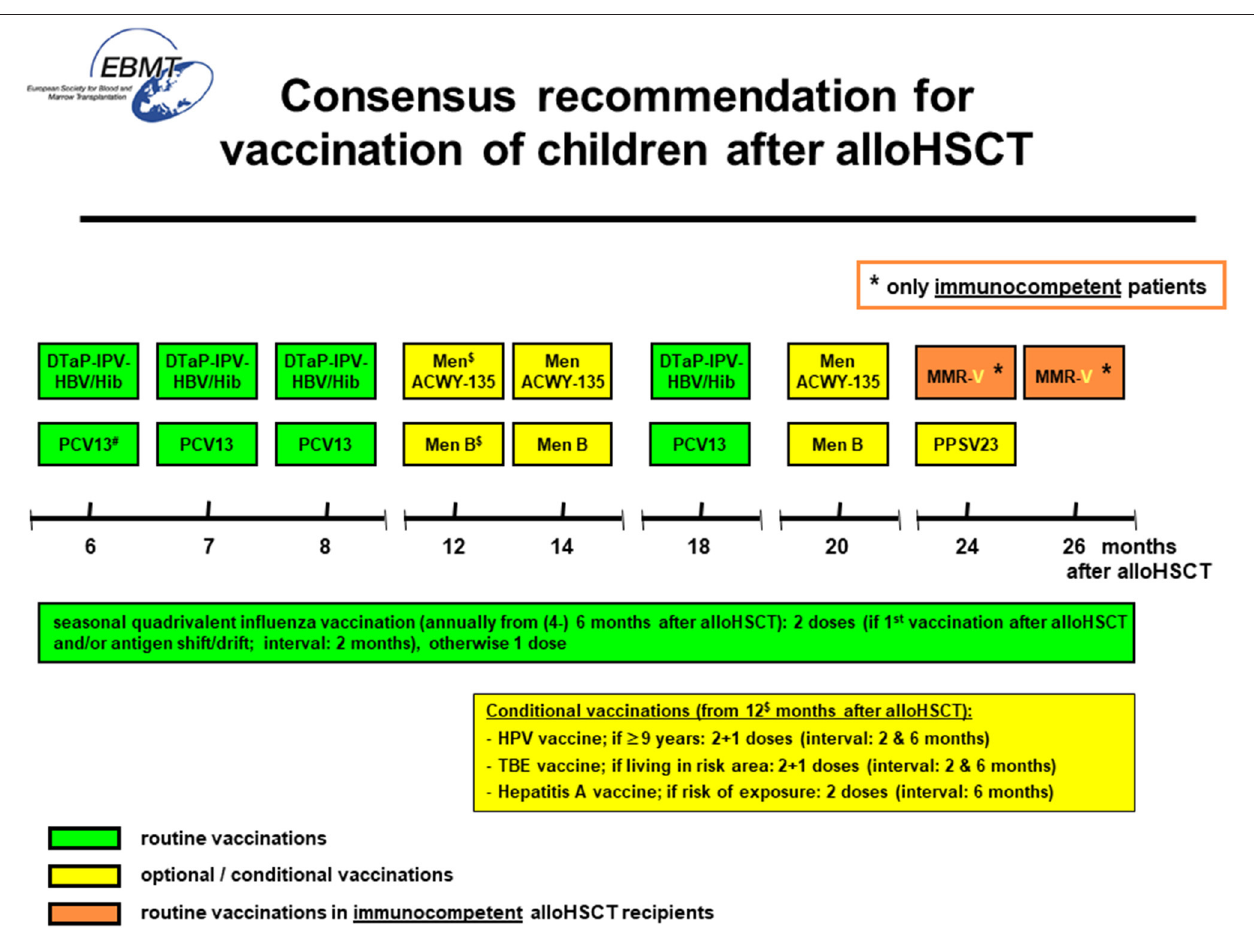
FIGURE 2 | Recommended and optional/conditional vaccinations after allogeneic hematopoietic cell transplantation in childhood. DTaP-IPV-HBV/Hib, hexavalent diphtheria, tetanus, acellular pertussis, inactivated poliovirus, hepatitis B, Haemophilus influenzae type B vaccine; PCV13, 13-valent pneumococcal conjugate vaccine; Men ACWY-135, quadrivalent meningococcal conjugate vaccine; Men B, recombinant meningococcal type B vaccine; PPSV23, 23-valent pneumococcal polysaccharide vaccine; MMR-V, live attenuated measles, mumps, rubella, varicella-zoster-virus vaccine; HPV, human-papilloma-virus vaccine; TBE, tick-born-encephalitis vaccine; HAV, hepatitis A vaccine. # start of vaccination at 3 months post-HSCT possible after individual risk-benefit analysis (please refer to text). $ start of vaccination at 6 months post-HCT possible after individual risk-benefit analysis (please refer to text). * only immunocompetent patients post-HSCT, if ≥ 3 months without immunosuppressive therapy and ≥ 3 months without active